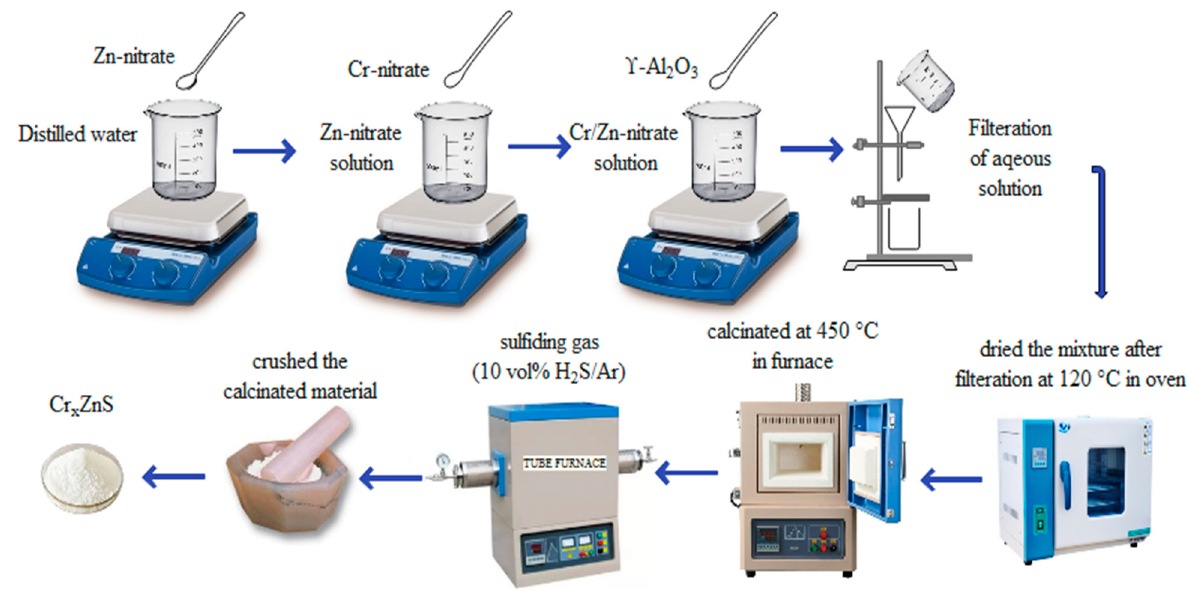
Figure 1. Illustration of the catalyst preparation procedure.